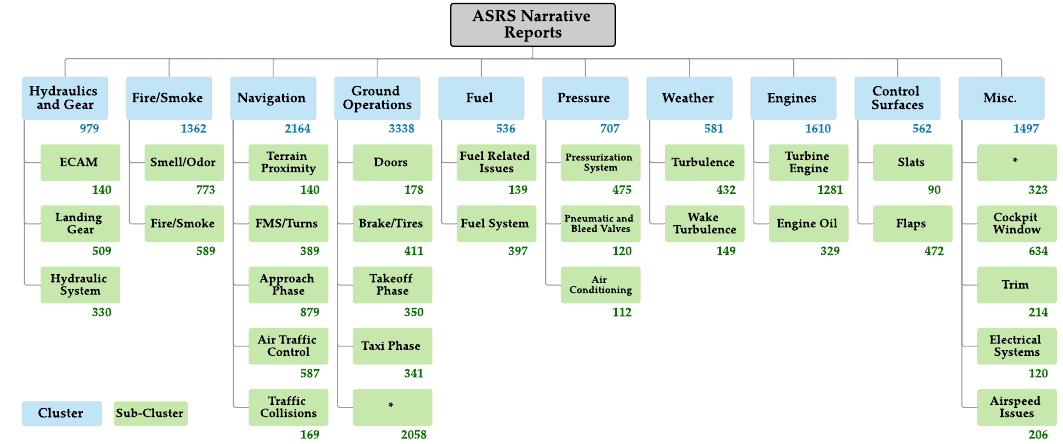
Figure 8. Sub-cluster hierarchy identified for each cluster.